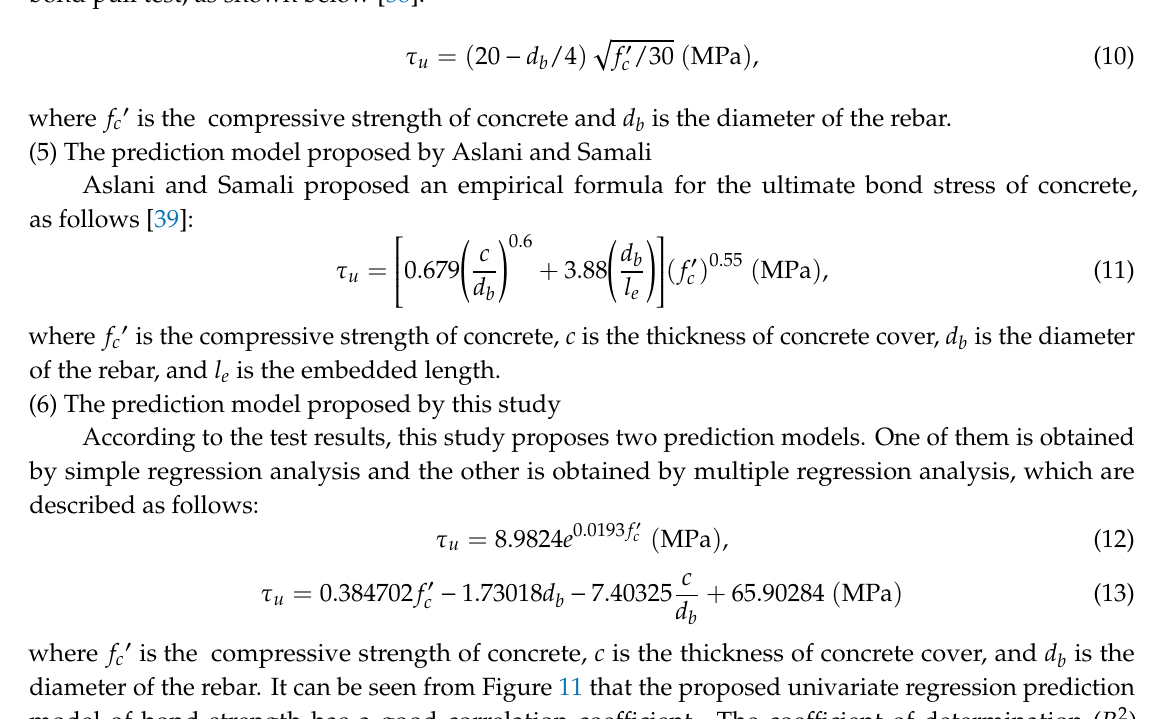
Table 7. Comparison of ultimate bond stress between the test result and prediction models. Specimen No.